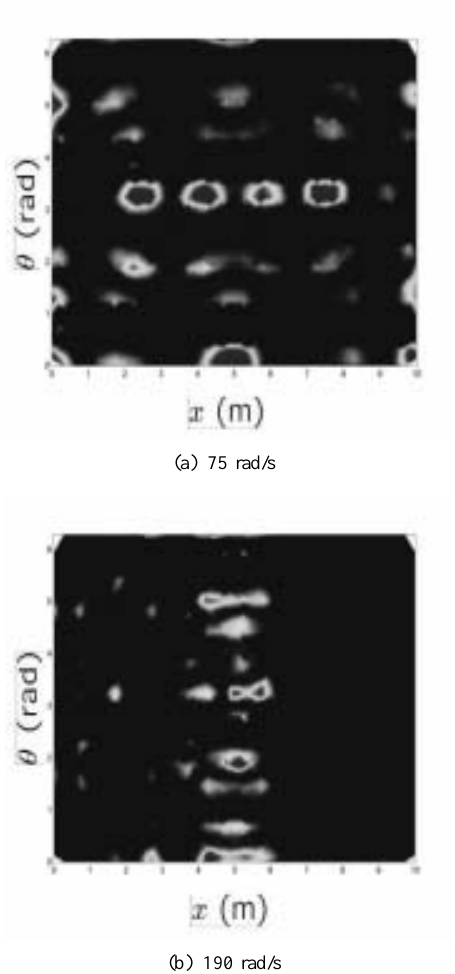
Fig. 13. Harmonic response for hexagonal grid with β = − 30 ◦